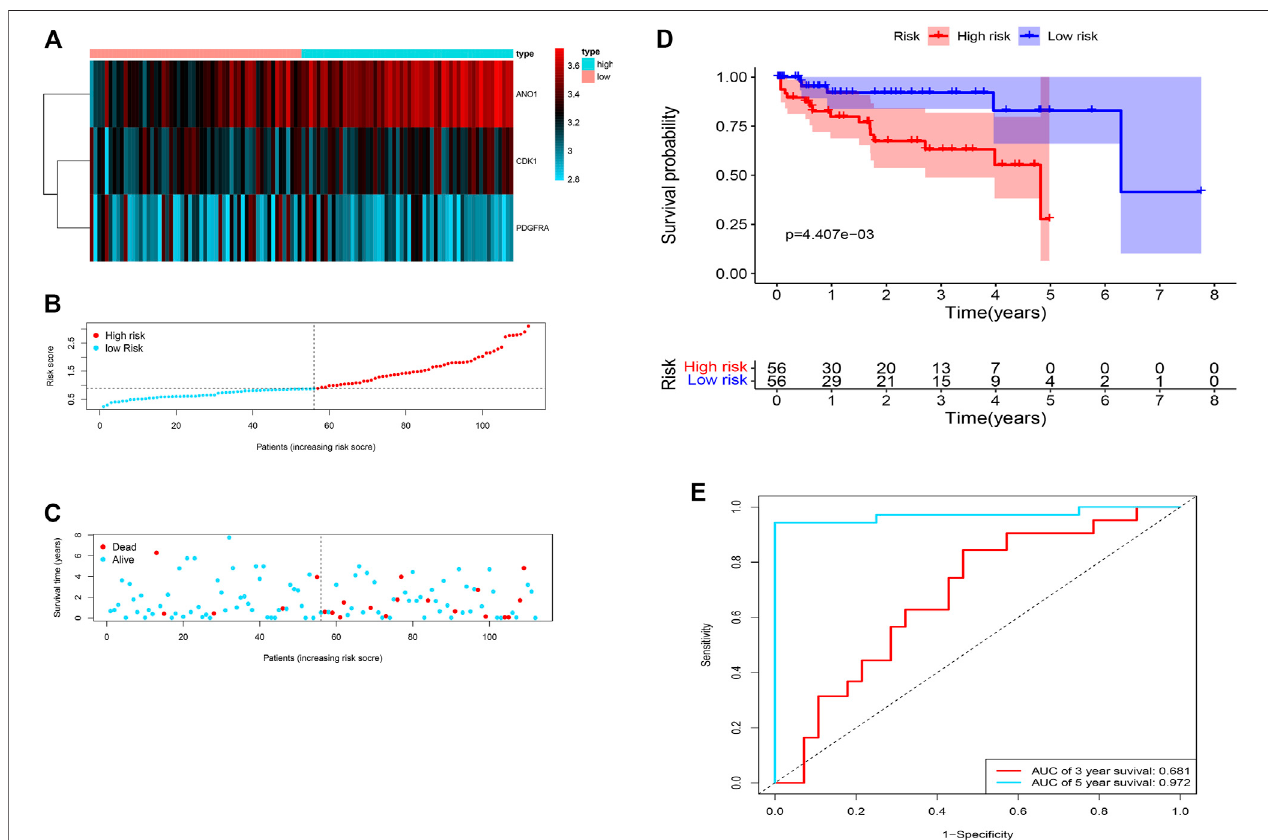
FIGURE 6 | Validation of the risk score in the GEO dataset. (A) Heatmap of the 3 differentially expressed m7G-related genes in the validation dataset. (B,C) Distributionofthesurvival,riskscore,andsurvivalofpatientswithHCC. (D) Survivalprobabilitybasedonthehighandlow-riskgroup. (E) ROCcurveforthe3-and5-year overall